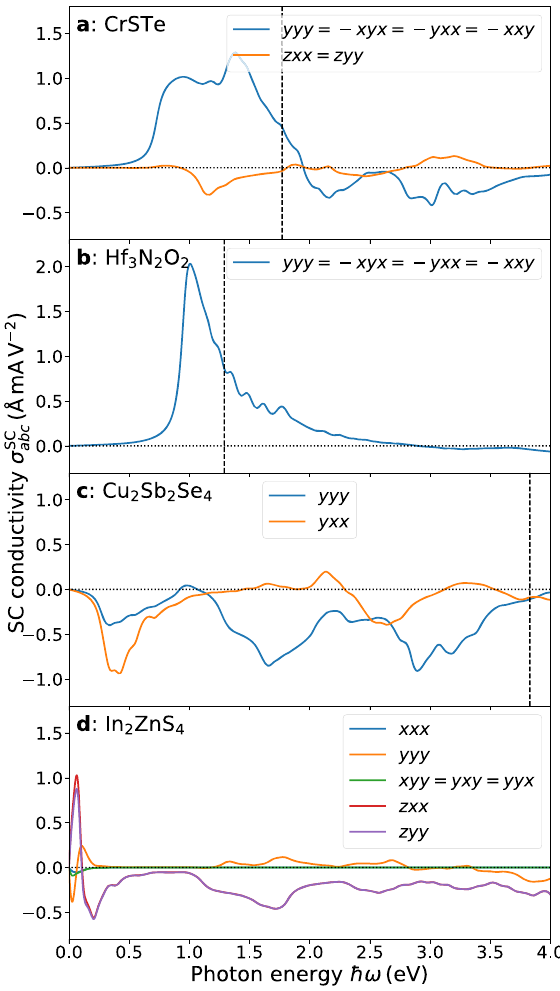
Fig. 5 Shift current spectra of selected materials. Shift current spectra of a CrSTe, b Hf 3 N 2 O 2 , c Cu 2 Sb 2 Se 4 , and d In 2 ZnS 4 , with a spectral broadening of 50 meV. Only tensor elements contributing to either ef fi ciencies or out-of-plane shift current are shown. The vertical dashed lines show the low-pass fi lter